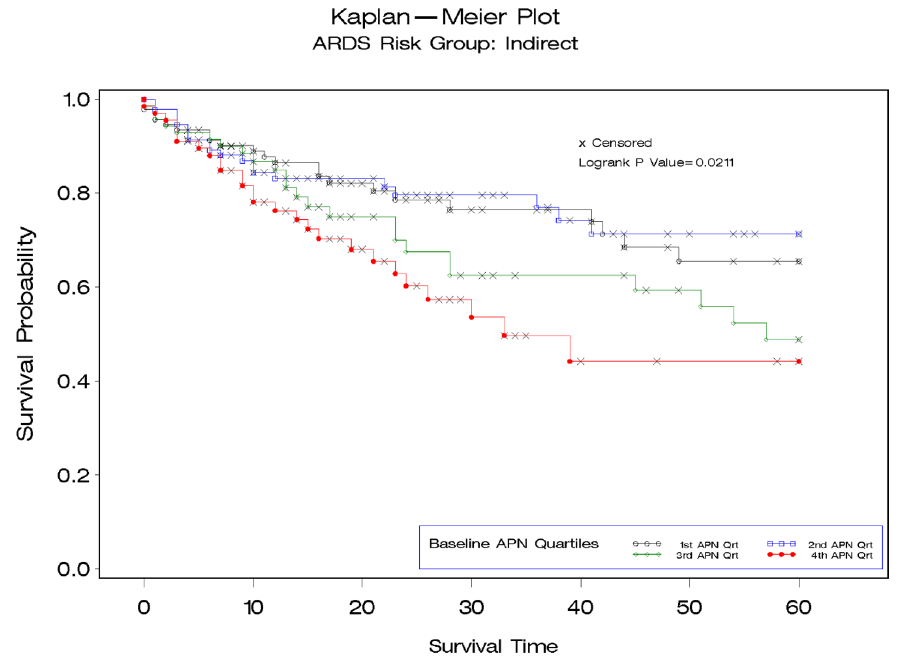
Figure 2. Kaplan-Meier survival plots demonstrating 60-day mortality for patients with acute respiratory distress syndrome stratified by quartile of baseline adiponectin (APN) level for patients with indirect lung injury (N=322). A significant interaction was demonstrated (p=0.016) for the association between baseline APN levels and mortality based on whether the mechanism of acute respiratory distress syndrome was presumed to be from ‘‘direct’’ pulmonary injury (eg., pneumonia, aspiration) or ‘‘indirect’’ injury from extra-pulmonary etiologies (eg., urosepsis, trauma, transfusion).